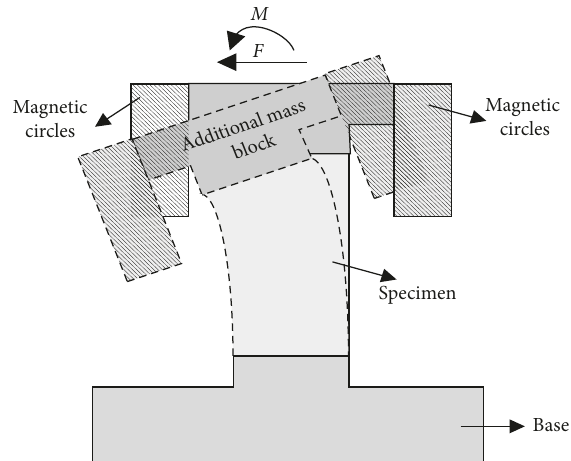
Figure 3: Model of lateral vibration with drive board.